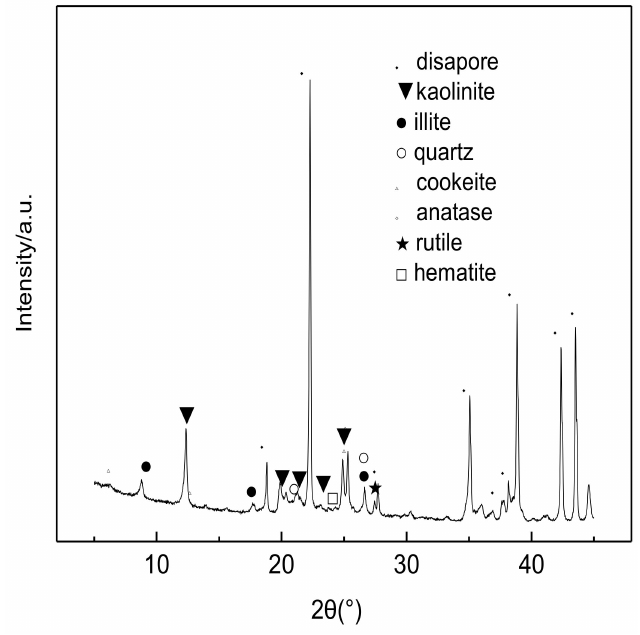
Figure 1. XRD pattern of lithium-bearing